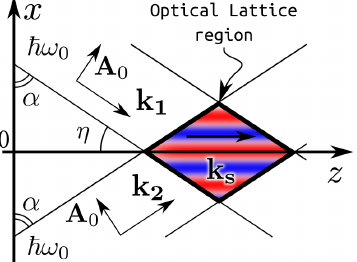
FIG. 1. The general scheme of the considered system. The effective potential channels (shown in color) axes are parallel to 0 z